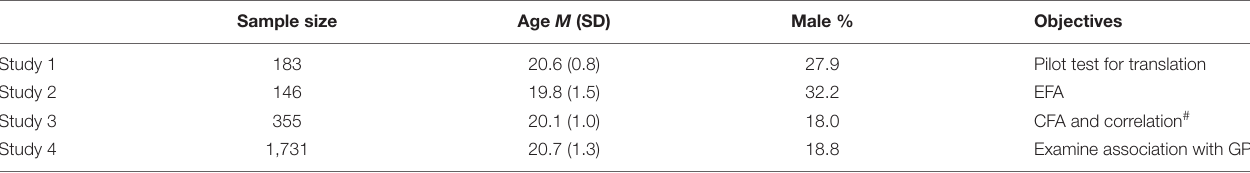
TABLE 1 | Brief descriptions of the four studies.